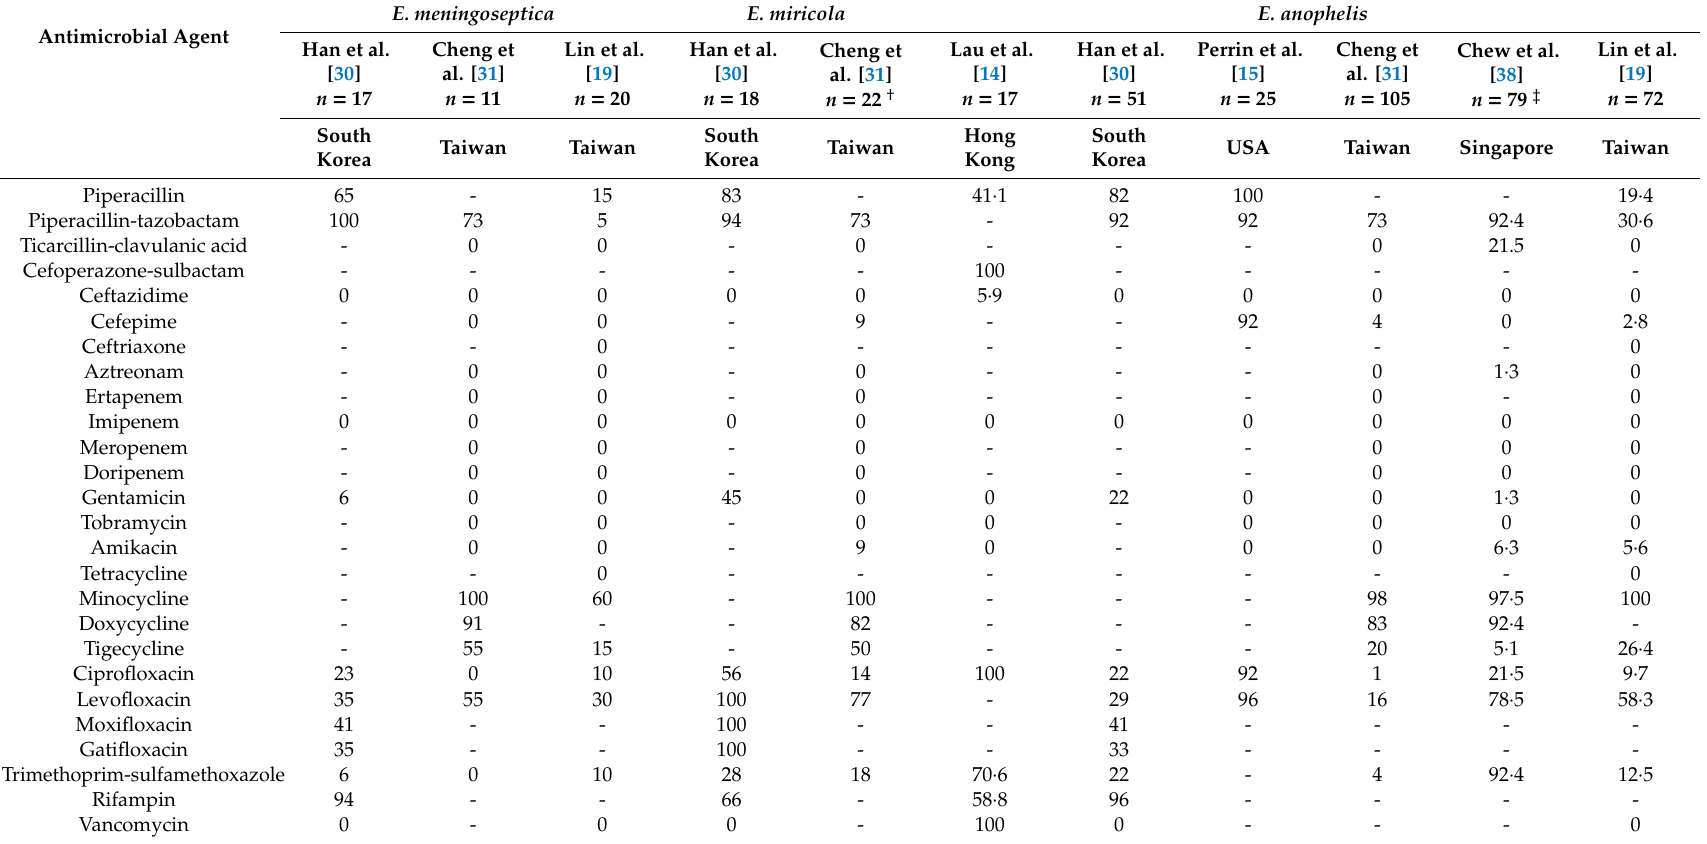
Table 3. The antibiotic susceptible rate of Elizabethkingia